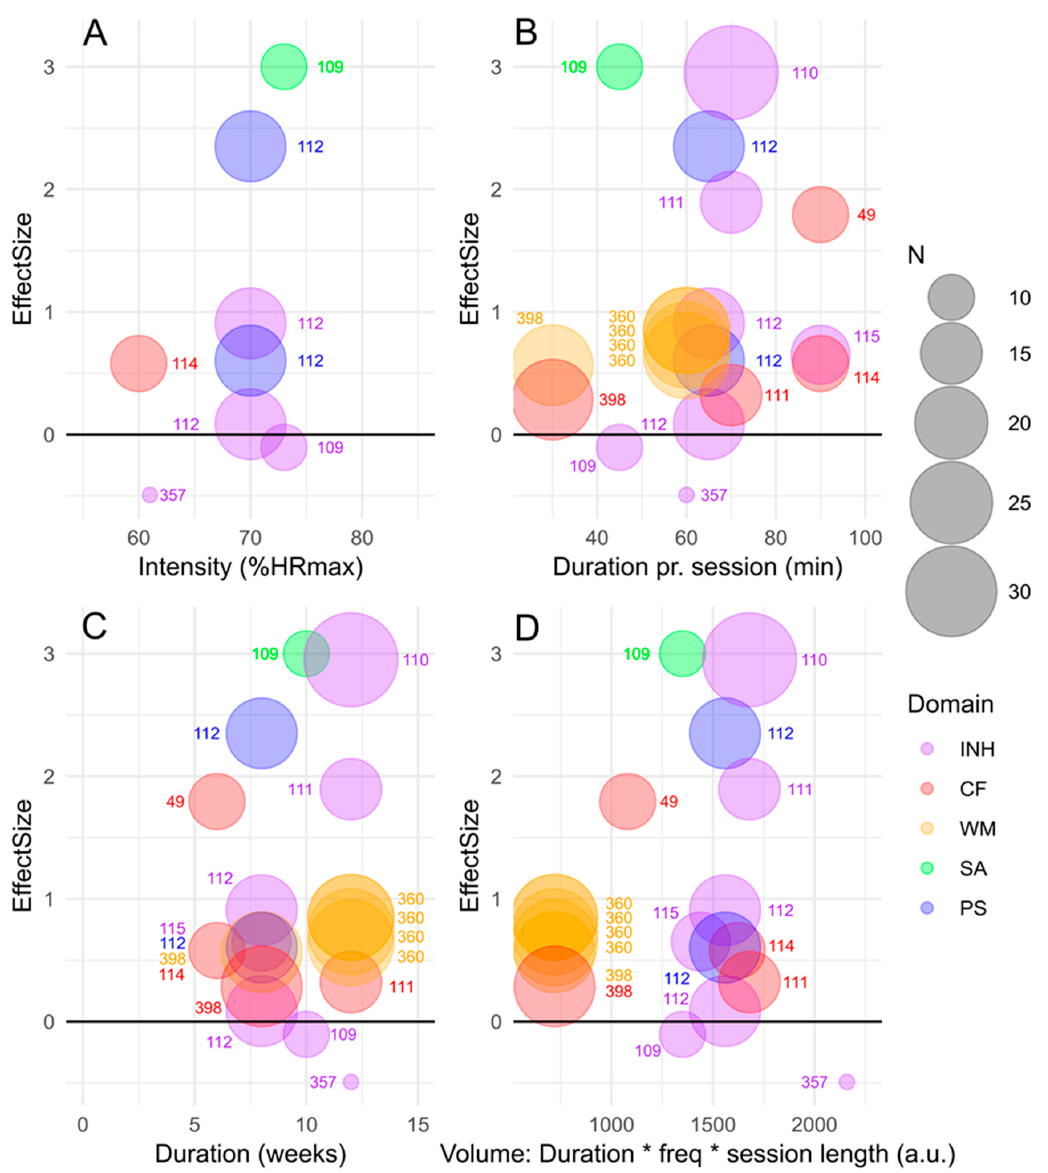
Figure 3. The effects of long-term exercise on cognitive performance for children with ADHD. The multi-plot illustrates extracted effect sizes color-coded by cognitive domain and plotted against exercise intensity ( A ), session duration ( B ), study duration ( C ) and volume (session-duration x session frequency x study duration, ( D ).